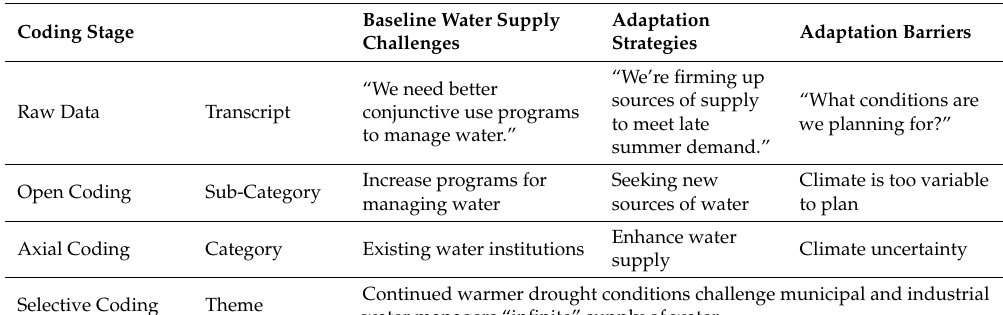
Table A2. Example coding for a municipal and industrial water manager illustrating the three stage coding